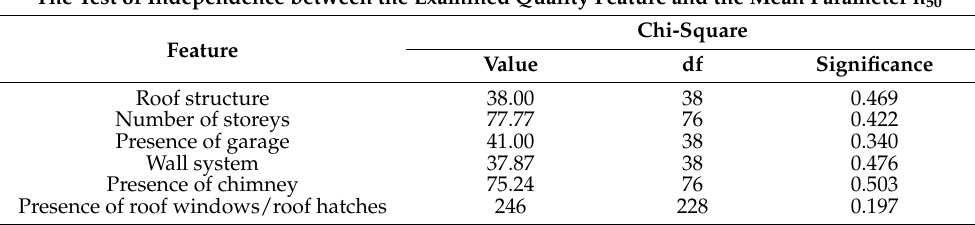
Table 10. Results of the chi-square test of independence for the analyzed qualitative variables. The Test of Independence between the Examined Quality Feature and the Mean Parameter n 50 Chi-Square Feature Value df Significance Roof